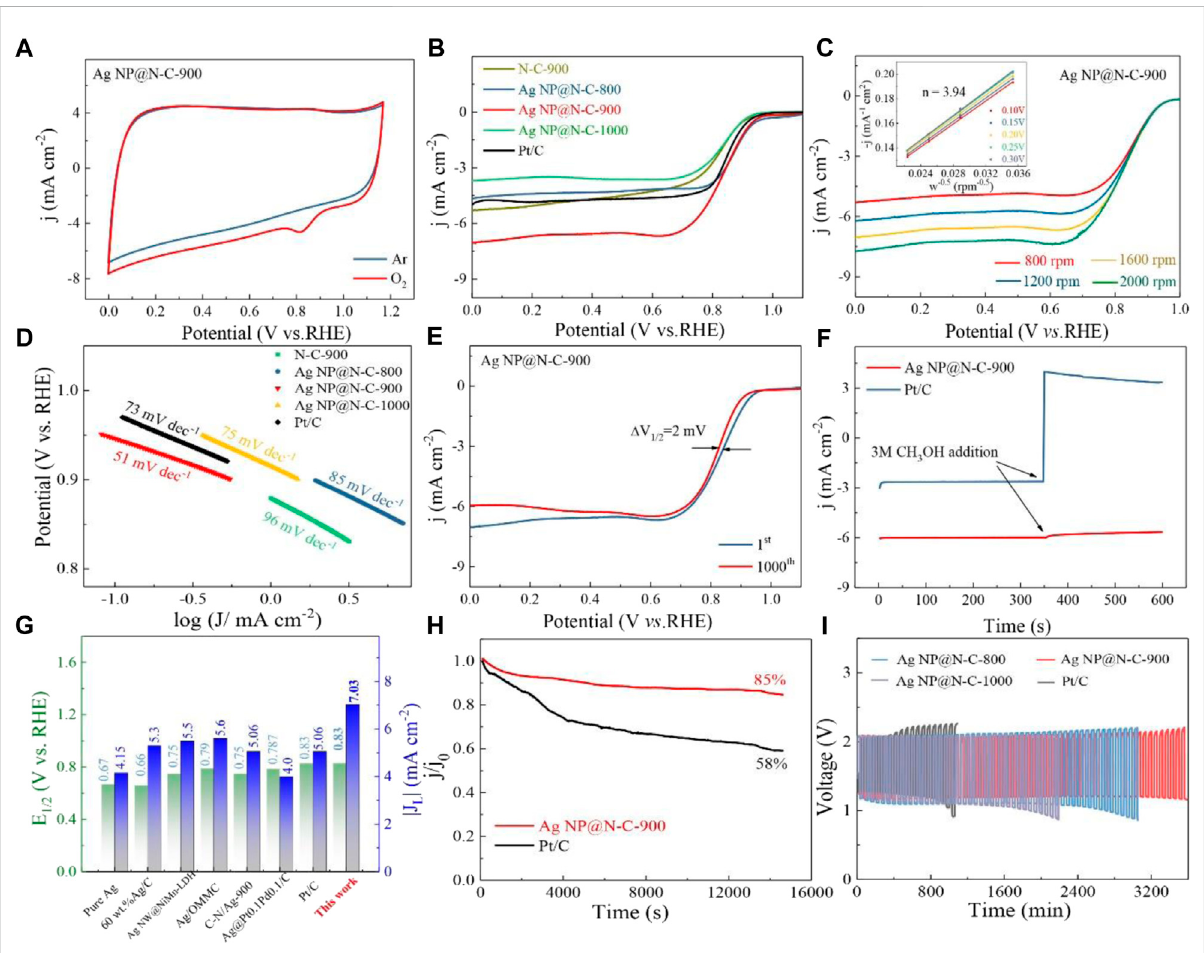
FIGURE 2 Catalytic properties. (A) CV curves oftheAg NP@N-C-900andthecommercialPt/Cin aAr and oxygen-saturated 0.1 MKOH solutions. (B) LSV curves of different samples in an oxygen-saturated 0.1 M KOH solutions at the scan rate of 5 mV s − 1 . (C) Polarization curves of the Ag NP@N-C- 900catalystatdifferentrotatingspeedsfrom800to2000 rpm.TheinsetshowsK-Lplotsatdifferentpotentials, (D) Tafelslopesofdifferentsamples, (E) LSV curves at different cycles of the Ag NP@N-C-900 samples in an oxygen-saturated 0.1 m KOH solutions at the scan rate of 5 mV s − 1 , (F) Methanol tolerance test by current – time ( i – t ) curves clock reaction, (G) Comparison of ORR performances, (H) Electrochemical stability for the